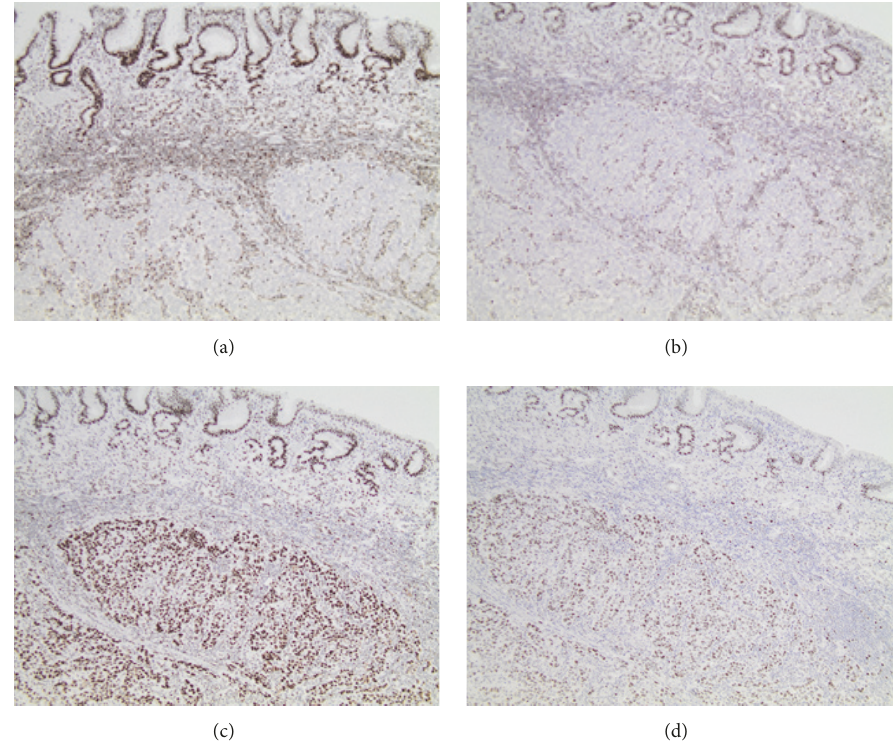
Figure 3: Mismatch repair protein expression immunohistochemical profile (100x). The gastric medullary carcinoma is located at the bottom half of each field, while the overlying unremarkable gastric mucosa is located at the top portion of each field. (a) Loss of MLH1 expression. (b) Loss of PMS2 expression. (c) Intact MSH2 expression. (d) Intact MSH6